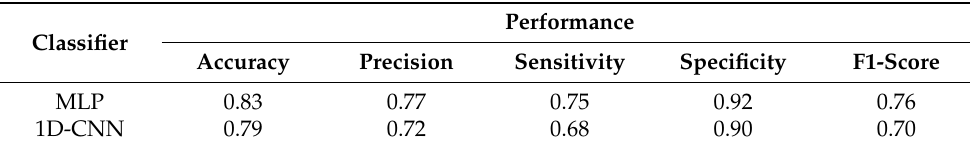
Table 1. Overall performance of the proposed classifiers.